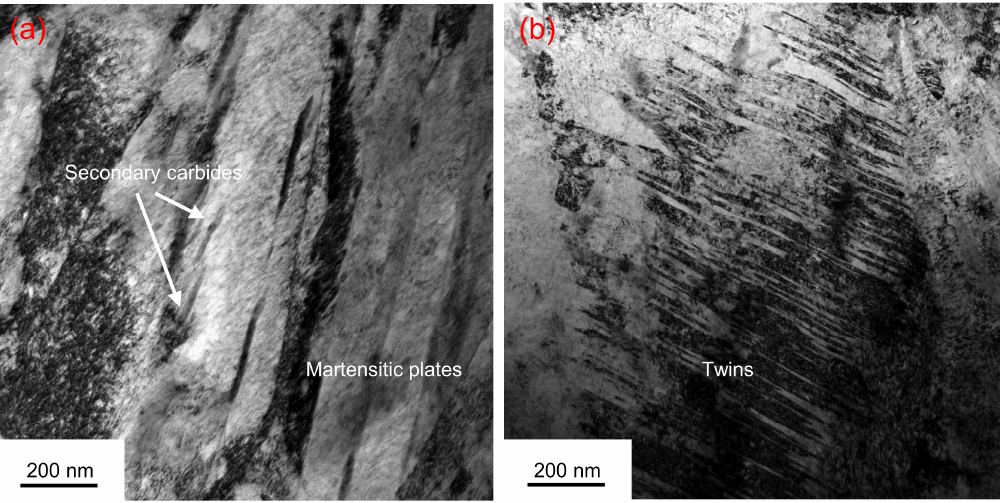
Figure 7. TEM micrographs of the original matrix of the M50 bearing steel: ( a ) TEM micrograph of the martensitic plates; ( b ) TEM micrograph of the twins.